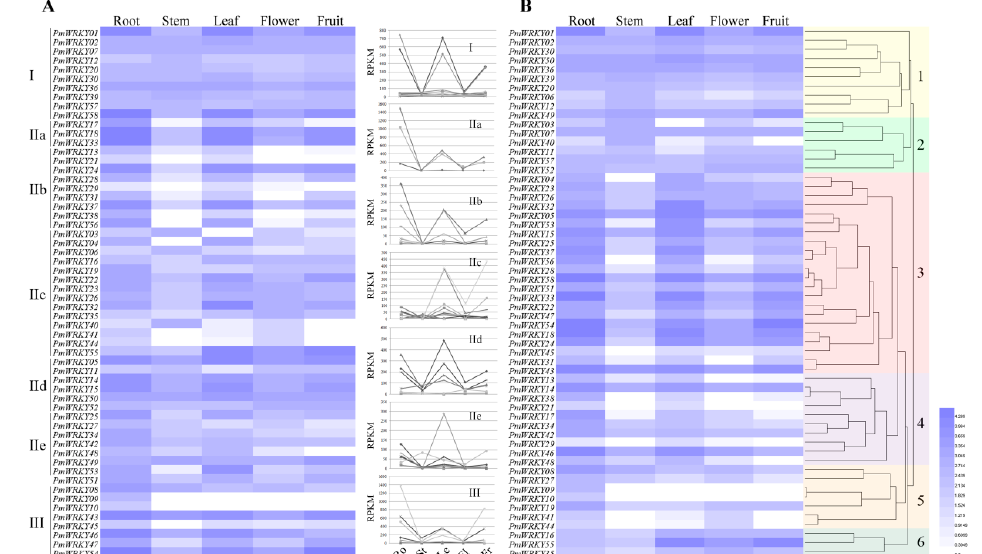
Figure 5. Expression patterns of PmWRKYs in five tissues. Transcriptome data was used to investigate expression profiles of PmWRKY genes. The colour scale represents RPKM expanded 25 times and then normalised log10 transformed counts. Light blue indicates low expression and dark blue indicate high expression. ( A ) Expression profiles related to subfamilies using heat map and line chart. ( B ) Hierarchical-clustering analysis of gene expression profiles.